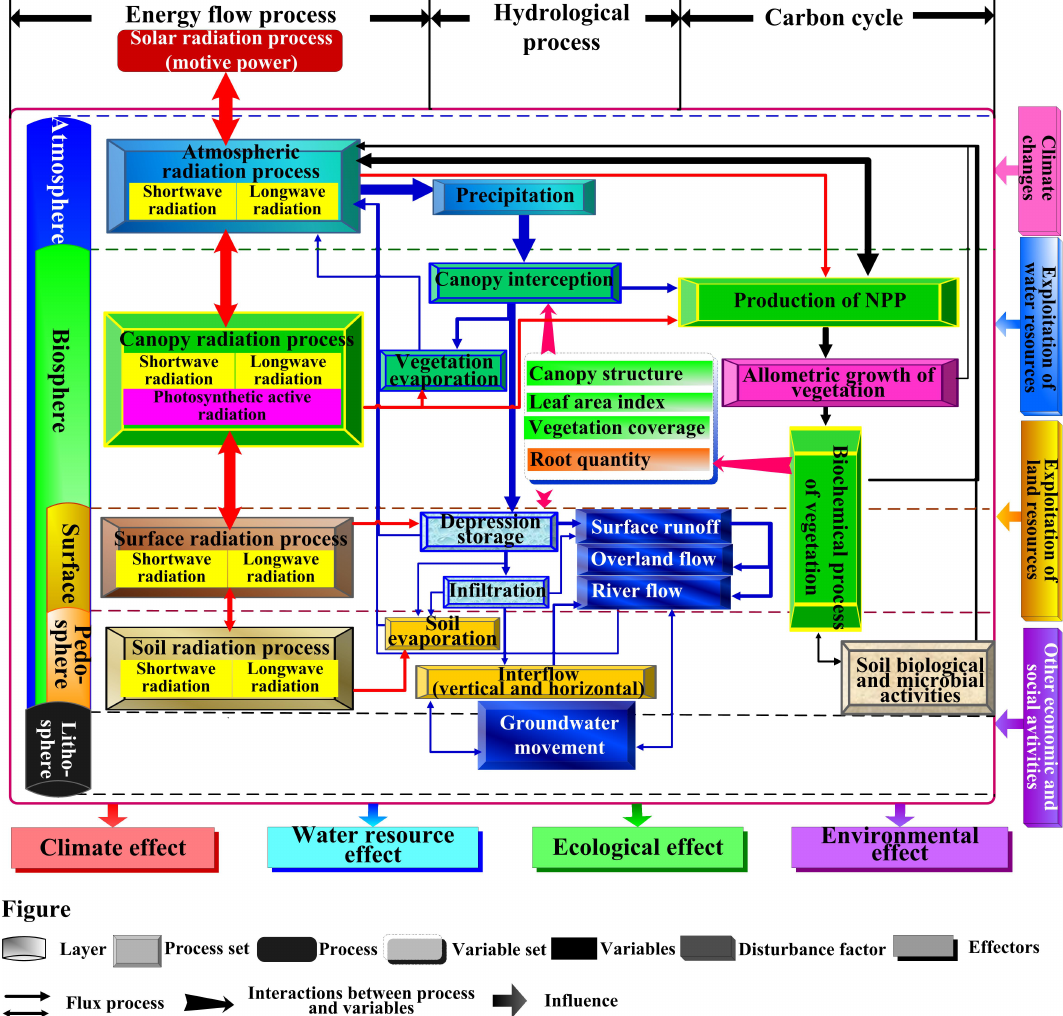
Fig. 3. Framework of climate-hydrology-ecology coupled simulation